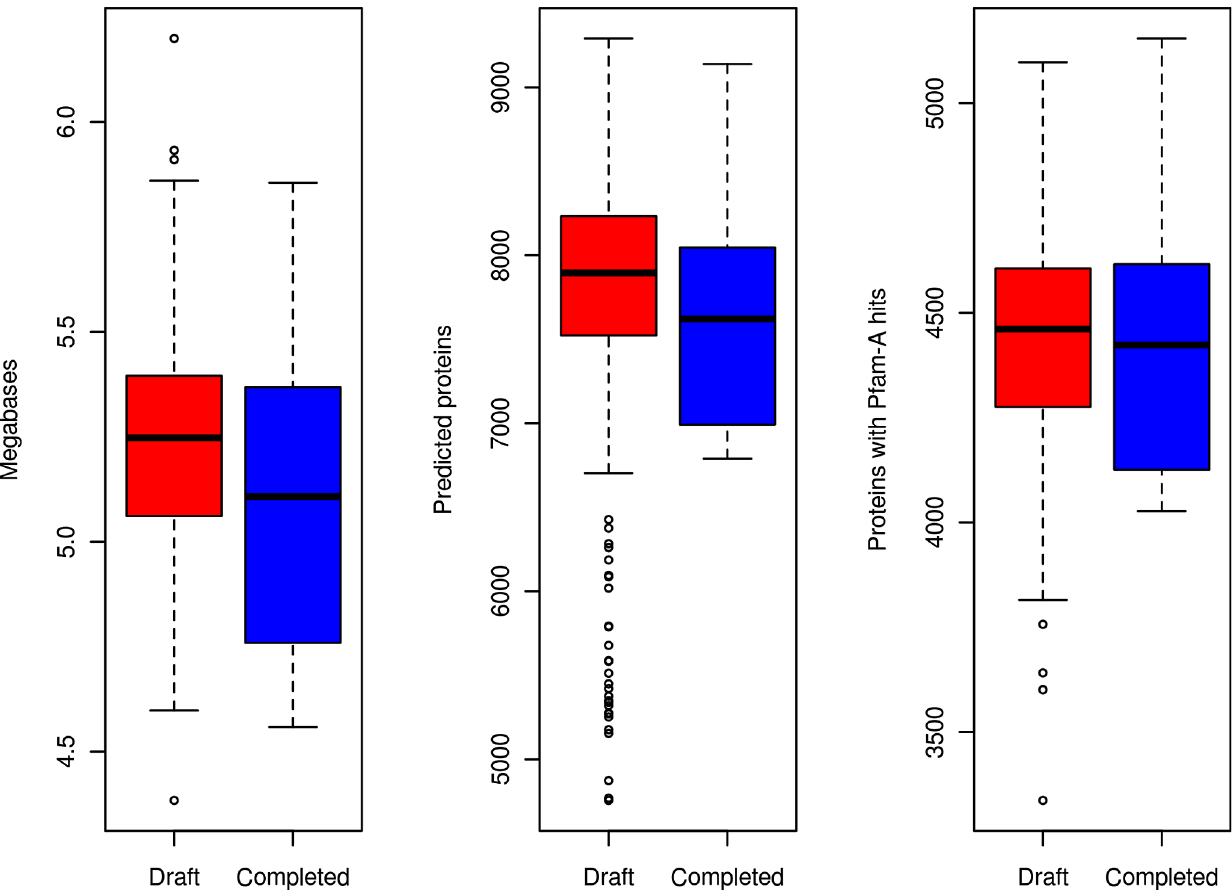
Figure 1. Complete and draft genomes. The box and whisker plots illustrate the differences between completed and draft genomes in this study. The left panel shows that the 56 complete genomes are somewhat smaller in size measured in megabases. This is most likely due to unresolved overlaps between the contigs in the draft genomes. The middle panel contains the number of unique genes predicted by the three gene finders after the elimination of all partial predictions (lacking start or stop codon). Notice the large number of predicted